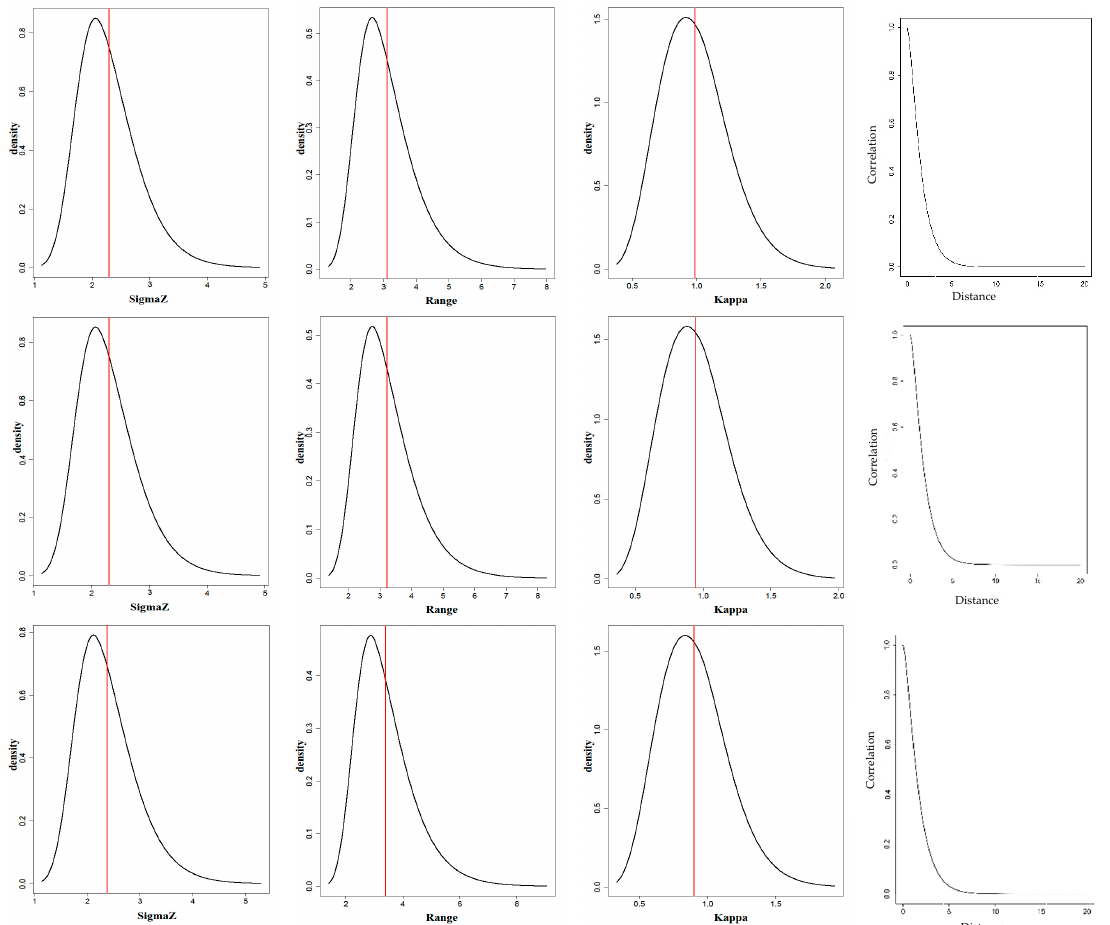
Figure 6. Posterior distribution of the parameters and Matern correlation function of the models. Note: The first and second rows represent the posterior distribution of parameters and the Matern correlation function curves of the stationary Gaussian model and the barrier model, and the third and fourth rows illustrate the posterior distribution of parameters and the Matern correlation function curves of the Multi-Barriers Model under different threshold values. The vertical line in the graphs indicates the posterior mean of the